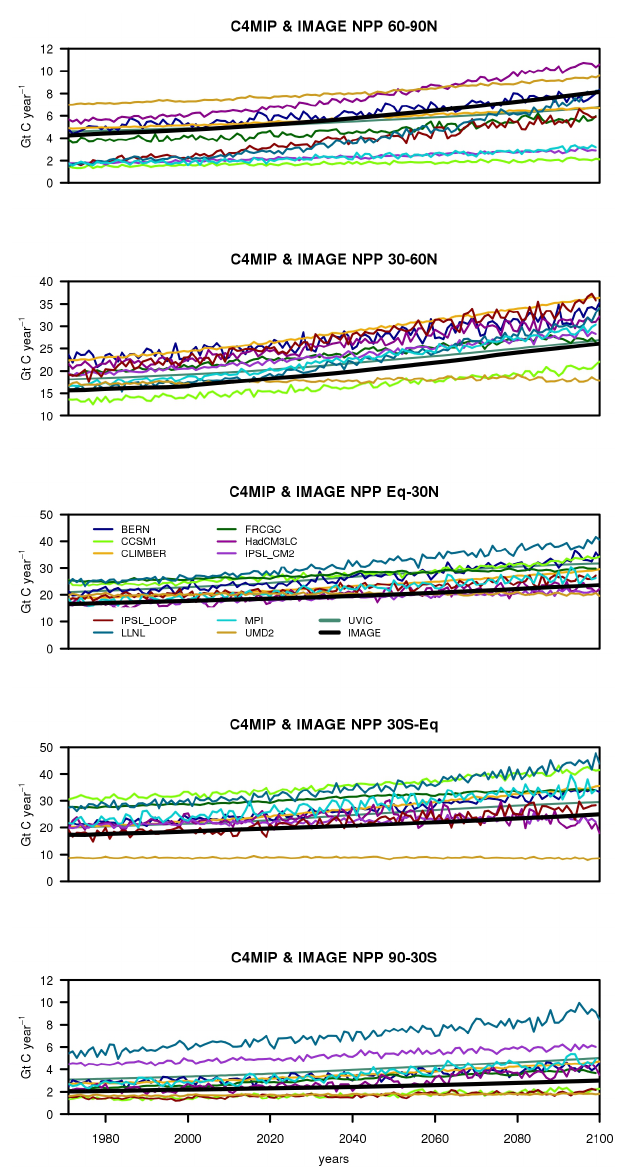
Fig. 2. Comparison of zonal NPP of IMAGE and C 4 MIP- simulations (Friedlingstein et al., 2006) for the SRES A2 emission scenario. Please refer to respective study for details on model ab-